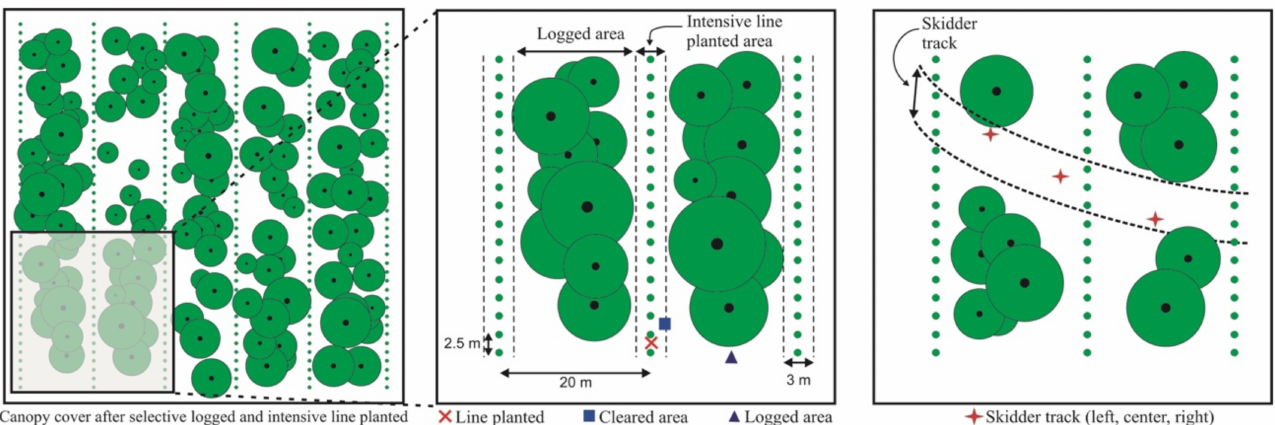
Figure 2. Infiltrometer test sites in line-planted, cleared, logged, and skidder-track